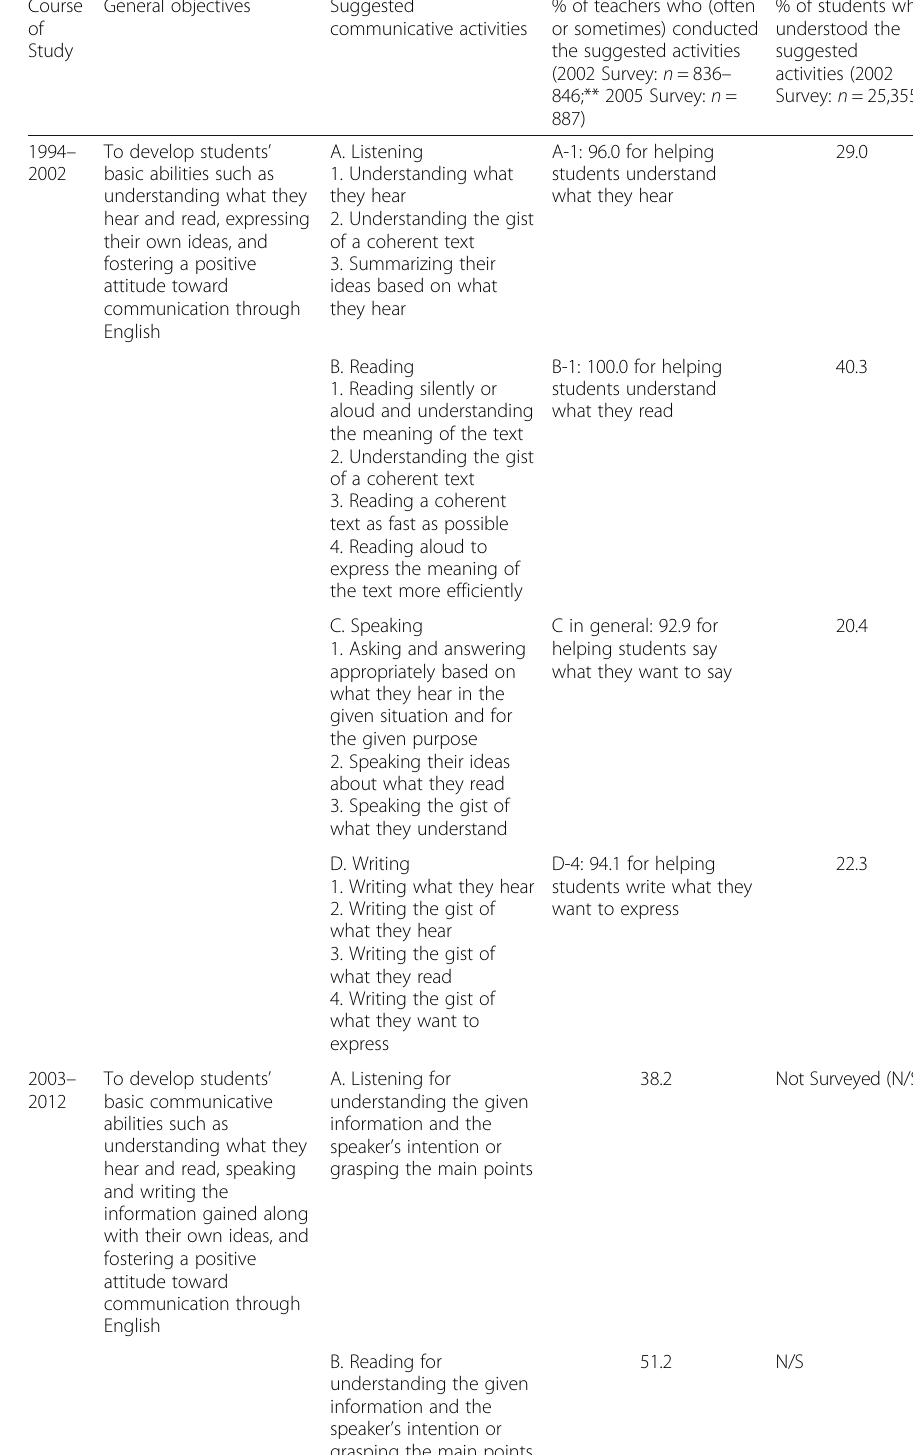
Table 1 Objectives, Suggested Communicative Activities, and Actual Classroom Practices for the 1994 – 2002 and 2003 – 2012 Courses of Study* Course